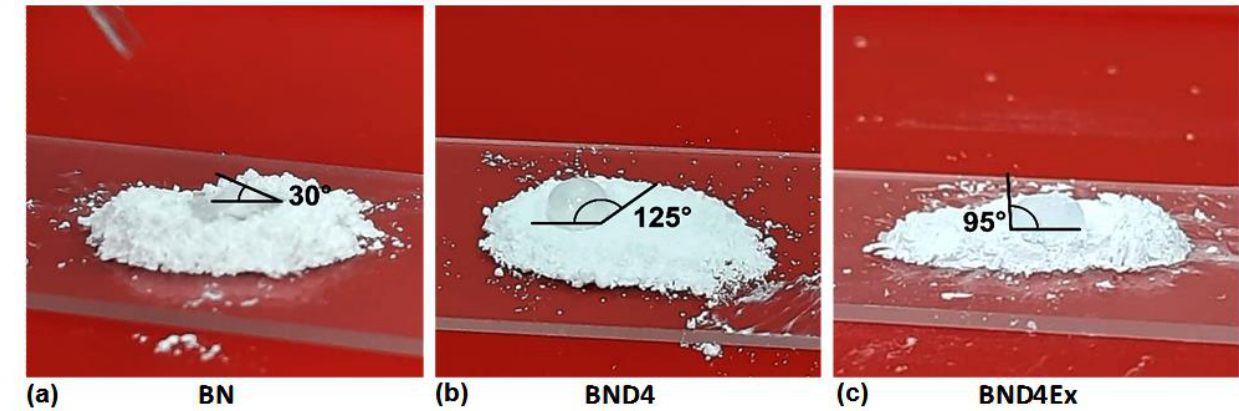
Figure 3. Photo images showing the shape of the water drop on the pristine BN powder ( a ) or treated differently: with D4 ( b ) and exfoliated after hydrophobization with D4 ( c ).